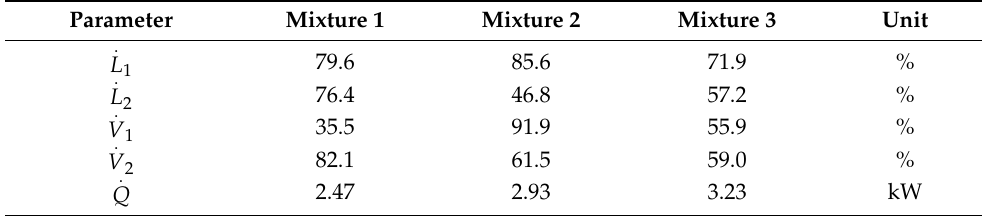
Table 7. Optimized operating points of all mixtures.